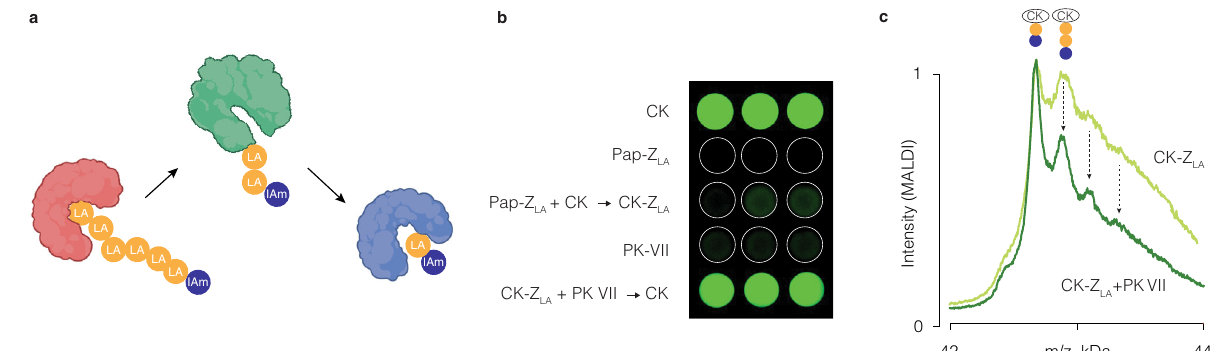
Fig. 7 | Two rounds of transfer of the polydisul fi de polymer between proteins. a Schematic illustration of the two-step chain transfer; b visualization of lumines- cence(read-out foractivity ofcreatine kinase viaa coupledluciferase-based assay) in solutions of CK, papain Z LA , and PK VII, as well as in solutions of papain Z LA with